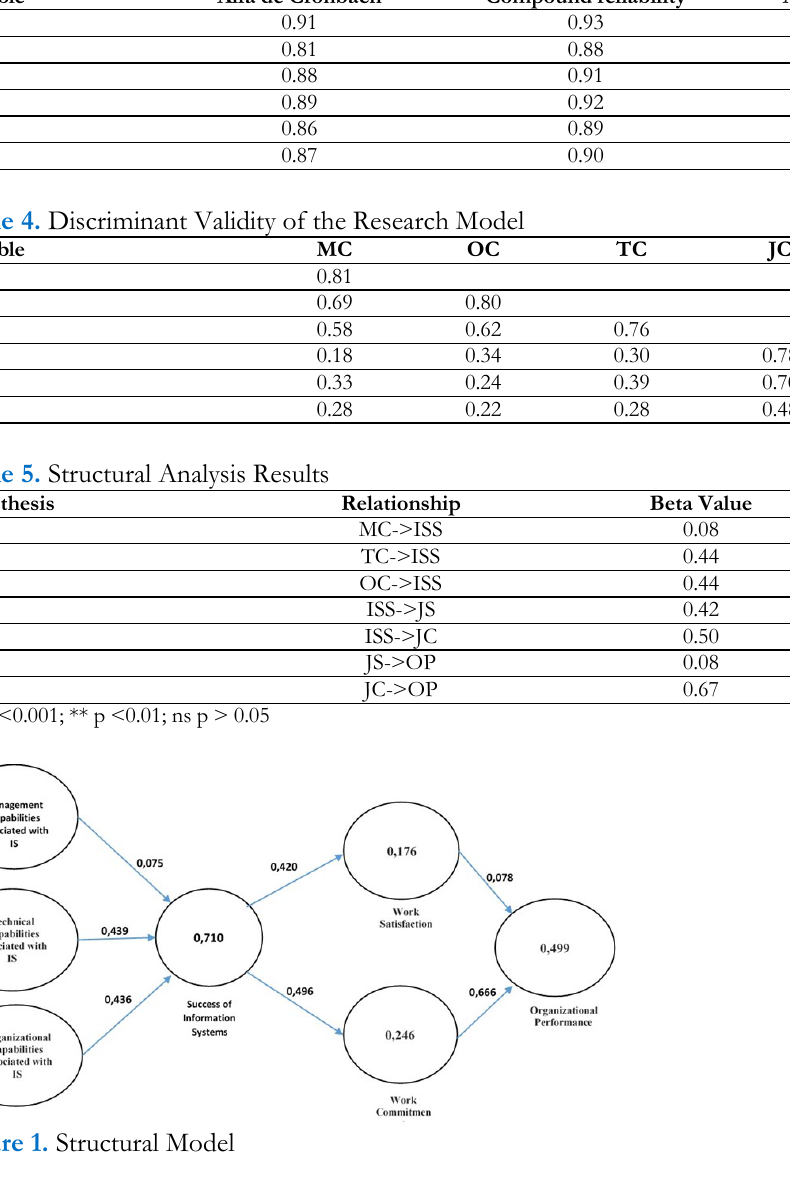
Table 3. Reliability and Validity Indices of the Research Model Variable Alfa de Cronbach